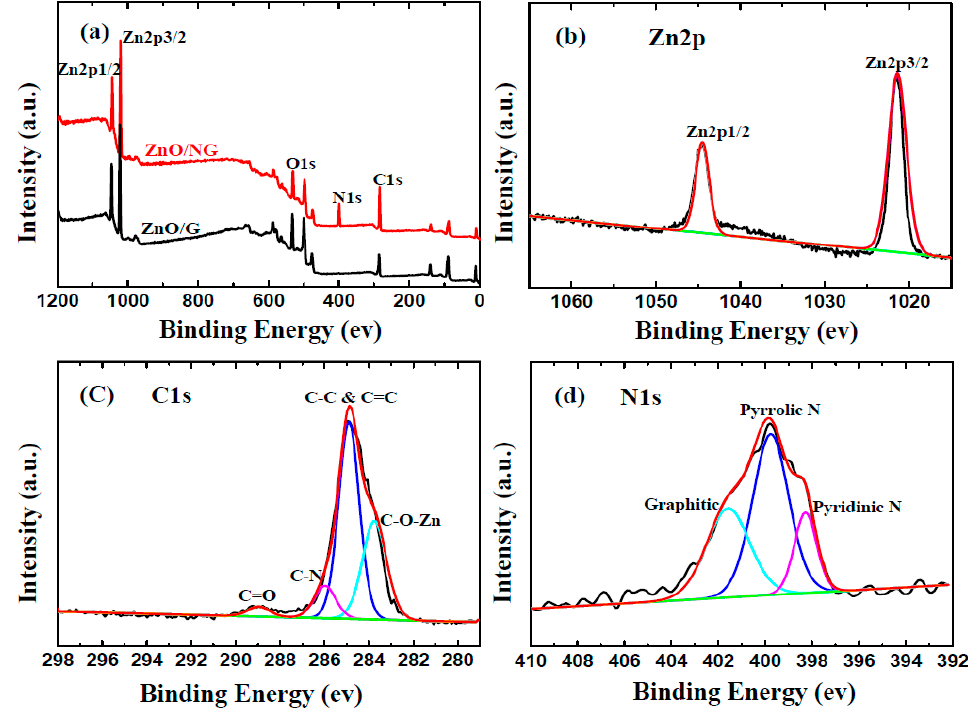
Figure 2. Survey XPS spectra ( a ) of ZnO/NG and ZnO/G composites; XPS spectra of ( b ) Zn2p, ( c ) C1s, and ( d ) N1s of ZnO/NG composite.